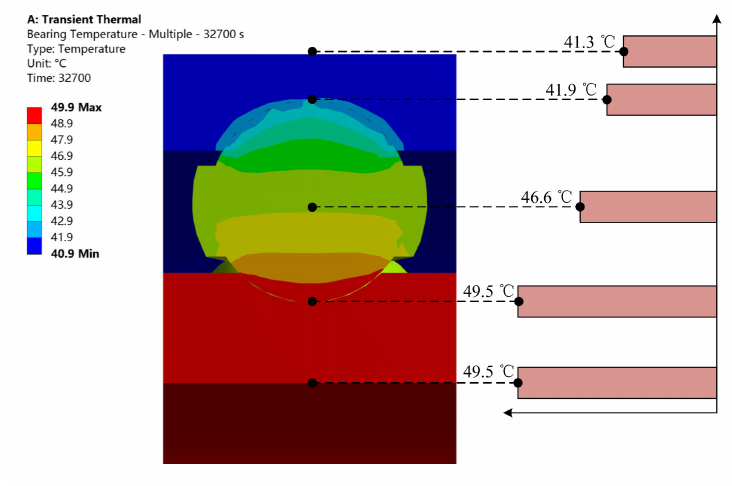
Figure 10. Temperature distribution on the centerline of the longitudinal section.